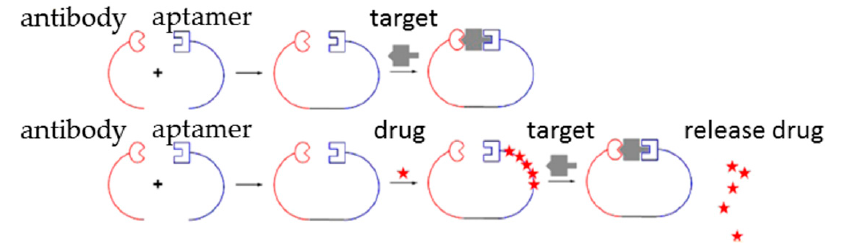
Figure 1. Aptamer-antibody conjugation can be used directly against the same target or for drug targeted delivery (Reproduced with permission from Reference [21]). Upper : Anti-thrombin antibody and anti-thrombin aptamer bind to different sites to thrombin. Conjugation of antibody and aptamer (AAP) has 100 and 35 fold higher affinity to thrombin than antibody and aptamer alone, respectively. For conjugation, amine-functionalized aptamer was maleimide activated by sulfosuccinimidyl 4-( N -maleimidomethyl) cyclohexane-1-carboxylate (sulfo-SMCC), and thio-functionalized antibody was conjugated to N -succinimidyl-S-acetylthioacetate (SATA). Then aptamer and antibody were mixed and incubated for covalent conjugation. Lower : Anti-human epidermal growth factor receptor 2 (HER2) aptamer was conjugated with anti-HER2 antibody by same conjugation method (AAP) and then loaded with doxorubicin (AAP-Dox). Folding of the aptamer which loaded Dox changes when aptamer binds to HER2, then Dox will be released from AAP-Dox. AAP-Dox has approximately three- and six-fold higher cytotoxicity than Dox alone and antibody alone, respectively